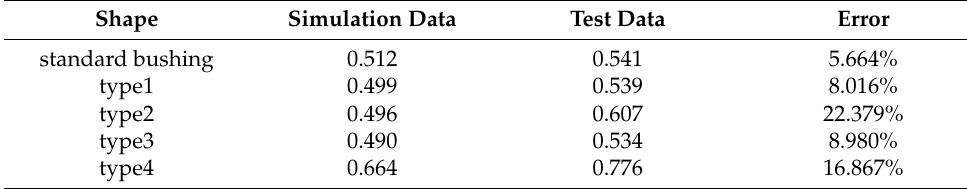
Figure 15. Scheme of the test system (M is for motor). Table 4. Maximum friction coefficient.